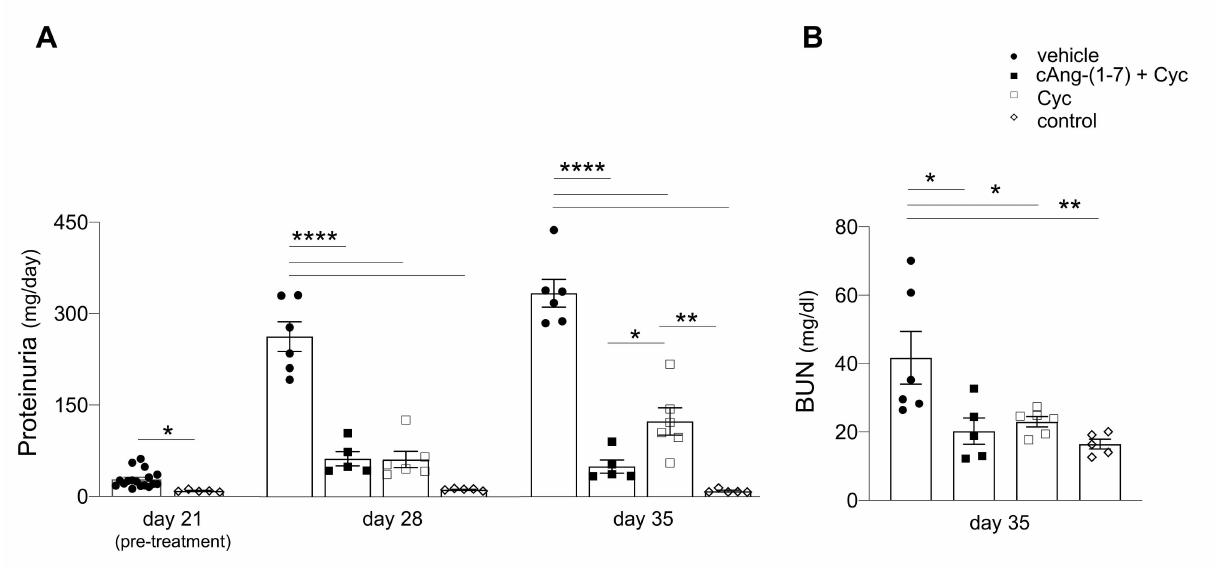
Figure 1. Treatment with cyclic Angiotensin-(1-7) (cAng-(1-7)) on top of cyclophosphamide (Cyc) blocks the rise of proteinuria and the impairment of renal function. ( A ) Time course of urinary protein excretion measured in WKY rats with ANCA-GN treated with vehicle ( n = 6), cAng-(1-7) plus cyclophosphamide ( n = 5) and cyclophosphamide alone ( n = 6), and WKY controls ( n = 5). Data are mean ± SEM. ( B ) Renal function evaluated as blood urea nitrogen (BUN) levels measured at the end of the study (day 35). Data are mean ± SEM. * p < 0.05, ** p < 0.01, **** p <